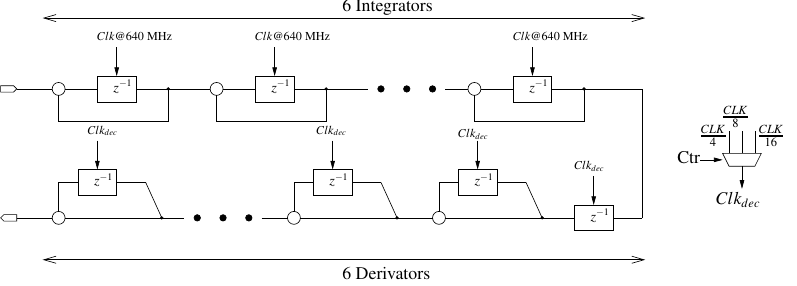
Figure 5. Comb filter.